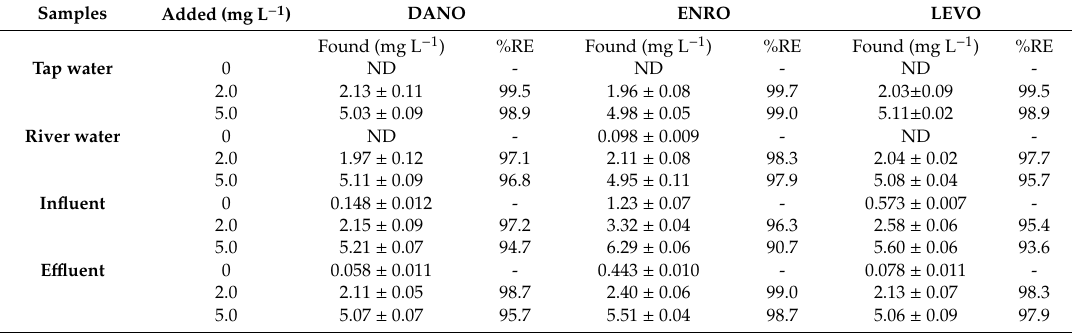
Table 8. Adsorptive removal of fluoroquinolones in wastewater, river water and tap water samples. Samples